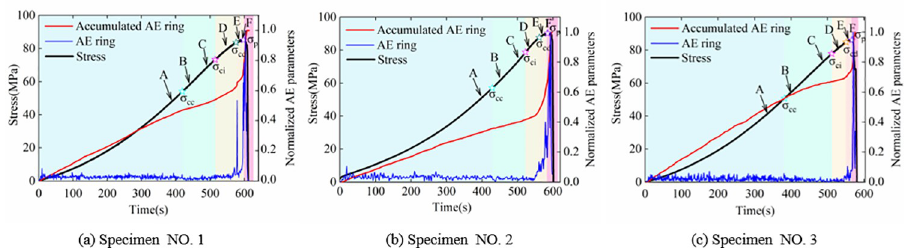
Fig 3. Time sequence evolution curves of stress and normalized AE parameters for the three